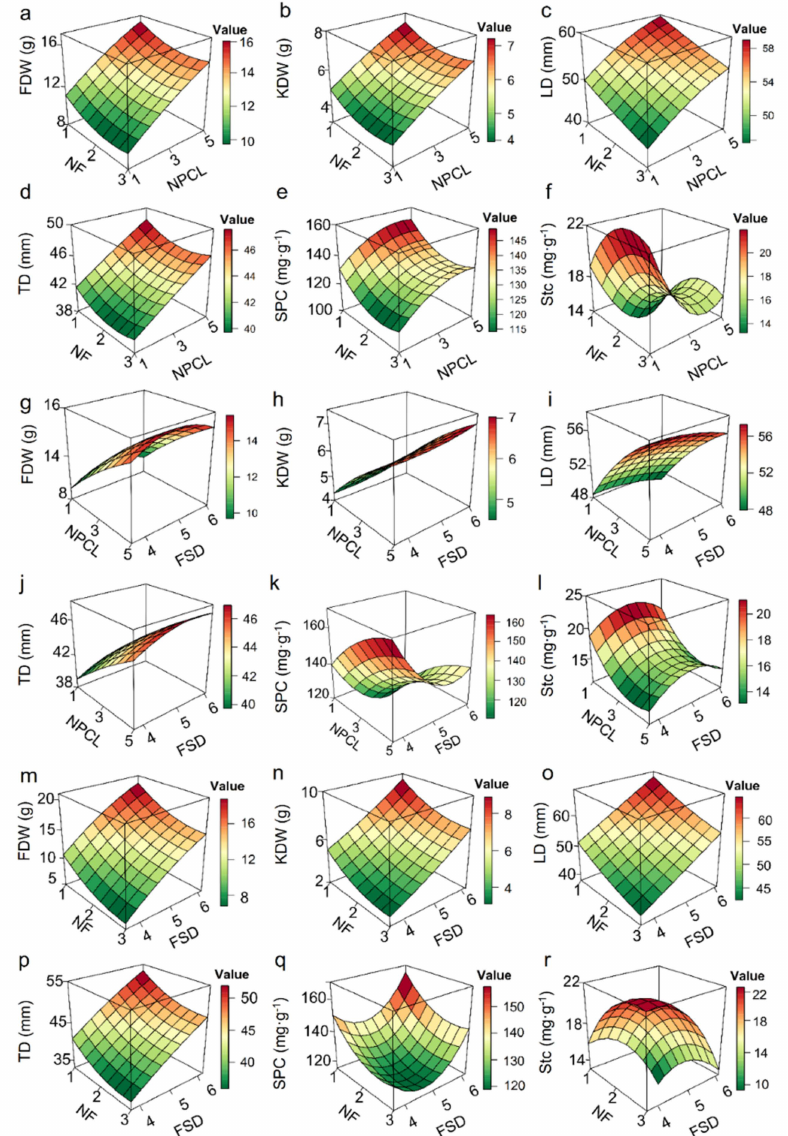
Figure 4. Response surface diagrams of binary quadratic models of the effects of two main target traits on fruit dry weight, longitudinal diameter, crude fat yield, and soluble protein yield. ( a – r ) The two agronomic traits in panels ( a – f ) are fruit number and leaf number, the two traits in panels ( g – l ) are leaf number and fruit stalk diameter, and the two traits in panels ( m – r ) are the leaf number and diameter of fruit–bearing